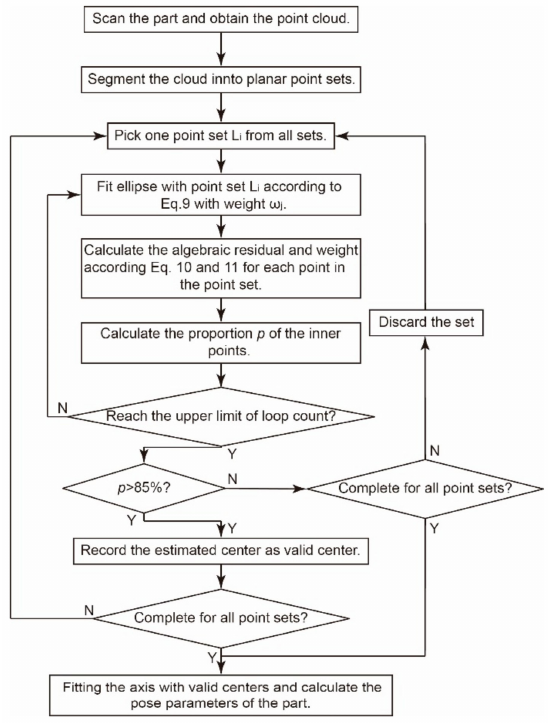
Figure 7. Flow diagram of the proposed robust